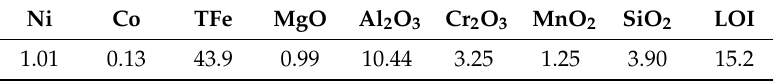
Table 1. Chemical composition of nickel laterite wt.%.